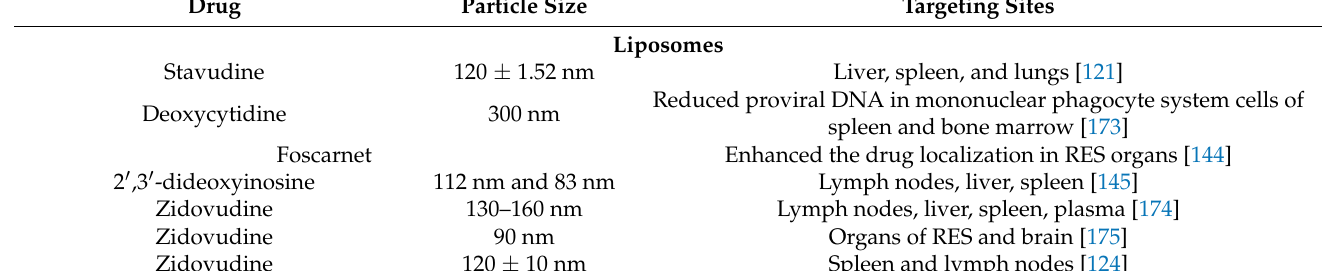
Table 4. Particle size-based nanocarriers for passive targeting